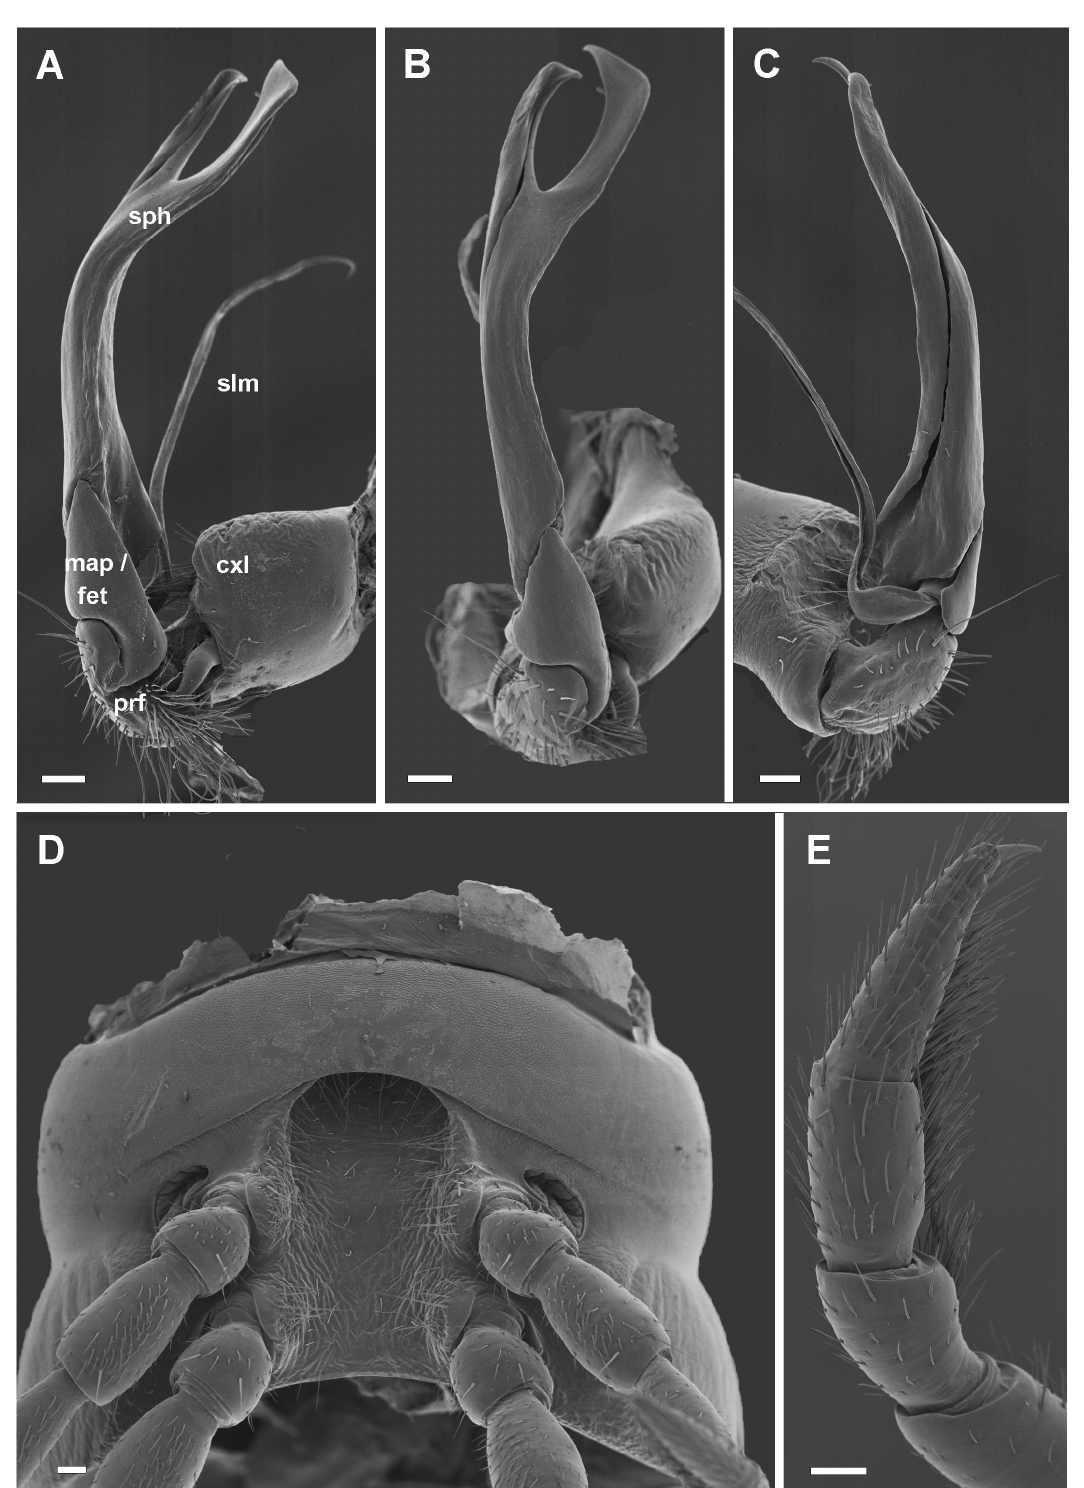
Fig. 39. Suohelisoma ulugurense Hoffman, 1964, specimen from Uluguru Mts, Lupanga, M. Stoltze and N. Scharff leg. A–C . Right gonopod. A. Mesal view. B. Ventral view. C. Lateral view. D . Body ring 6 showing excavated sternum, ventral view. E . Anterior leg, showing scopulae. Abbreviations: cxl = coxal lobe; map / fet = mesal acropodital process / ʻfemoriteʼ; prf = prefemoral part; slm = solenomere; sph = solenophore. Scale bars: 0.1